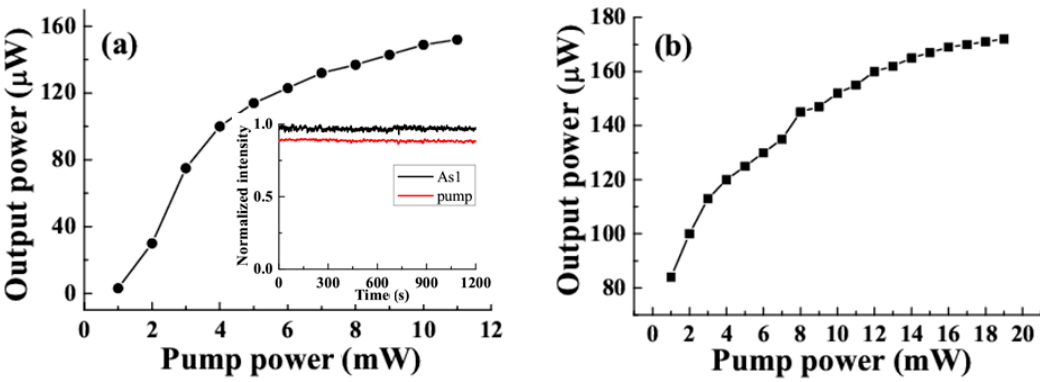
Figure 10. The power dependence of AS1 on ( a ) Beam 1 with power of Beam 2 fixed at 19 mW, and ( b ) Beam 2 with power of Beam 1 fixed at 11 mW. Power stabilities of AS1 and Beam 1 in twenty minutes are shown as the insertion of ( a )